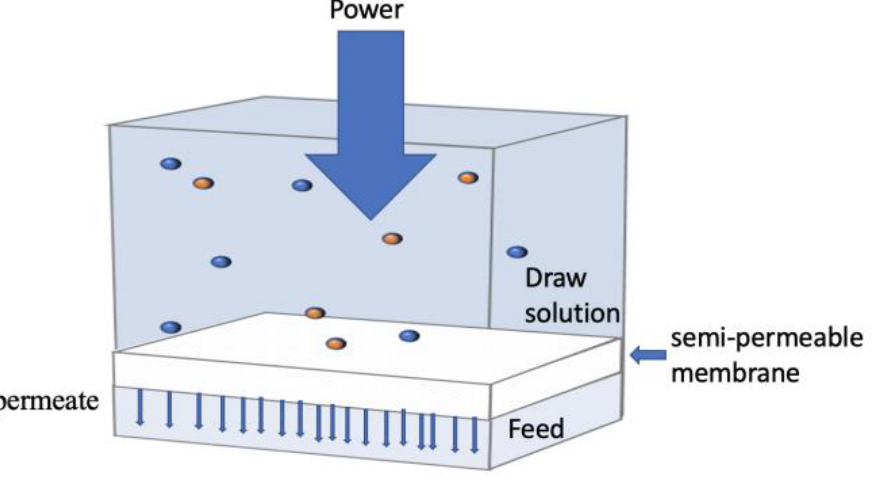
Figure 6. RO membrane process principle.